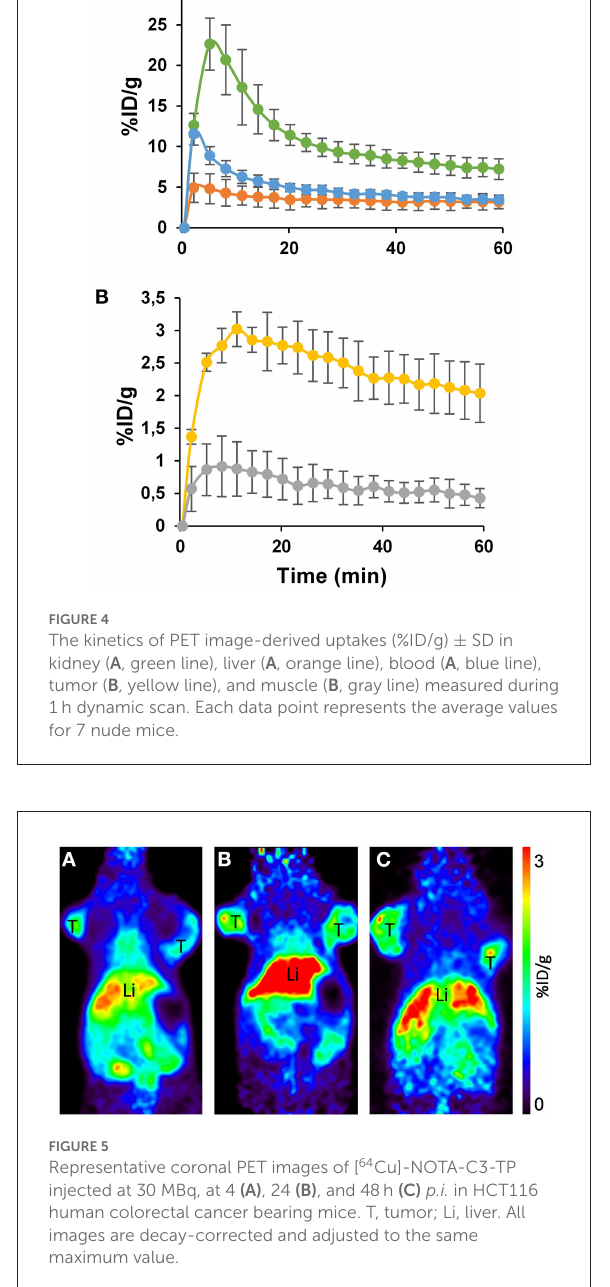
%ID/g at 1h (Figure 4A, blue line). In the muscle, the %ID/g has remained below 1% ranging from 0.9 ± 0.3 to 0.4 ± 0.1 %ID/g during the whole dynamic scan (Figure 4B, gray line).